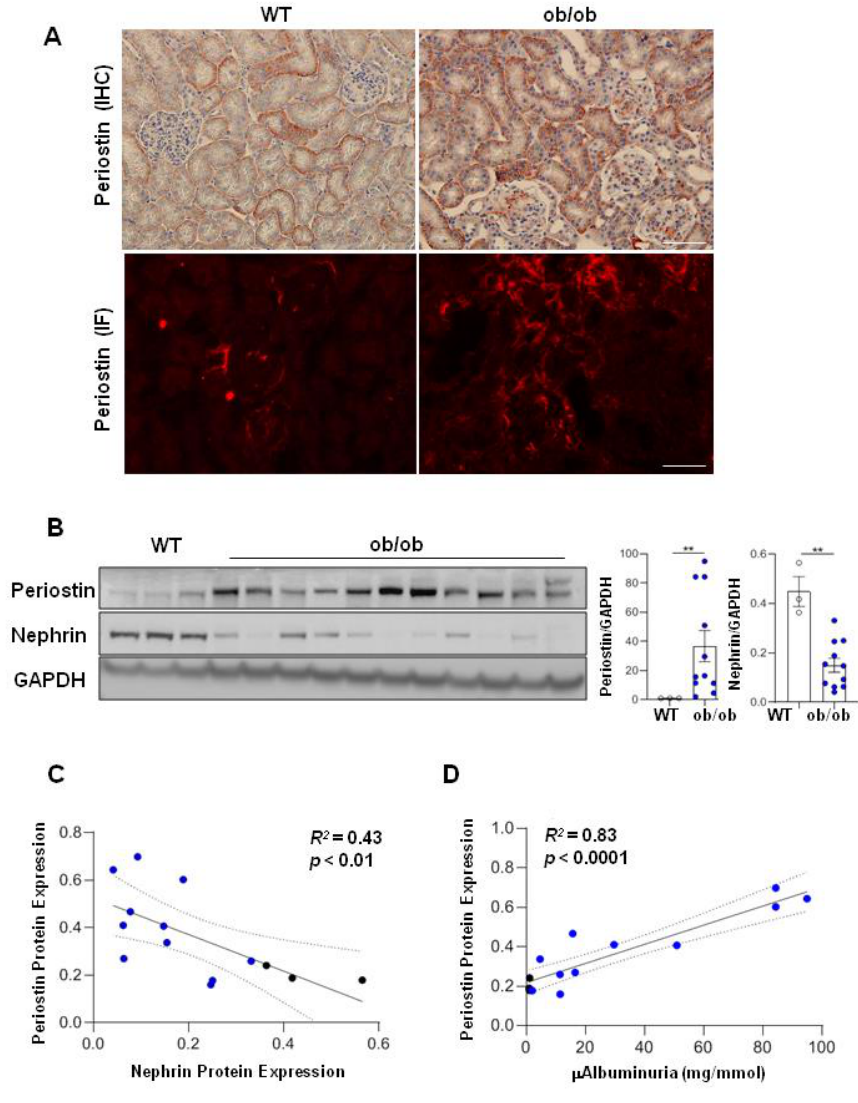
Figure 2. Periostin is associated with the degree of renal injury in diabetic ob/ob mice. Representative immunostaining of periostin tissue expression in kidneys by immunohistochemistry and immunoflu- orescence comparing WT and ob/ob mice ( × 200) ( A ). Periostin and nephrin protein expression in kidneys of WT ( n = 3) and ob/ob mice ( n = 11) ( B ). Correlations between periostin and nephrin ( C ) or µ Albuminuria ( D ). ** p < 0.01, compared to WT control. Bars = 50 µ